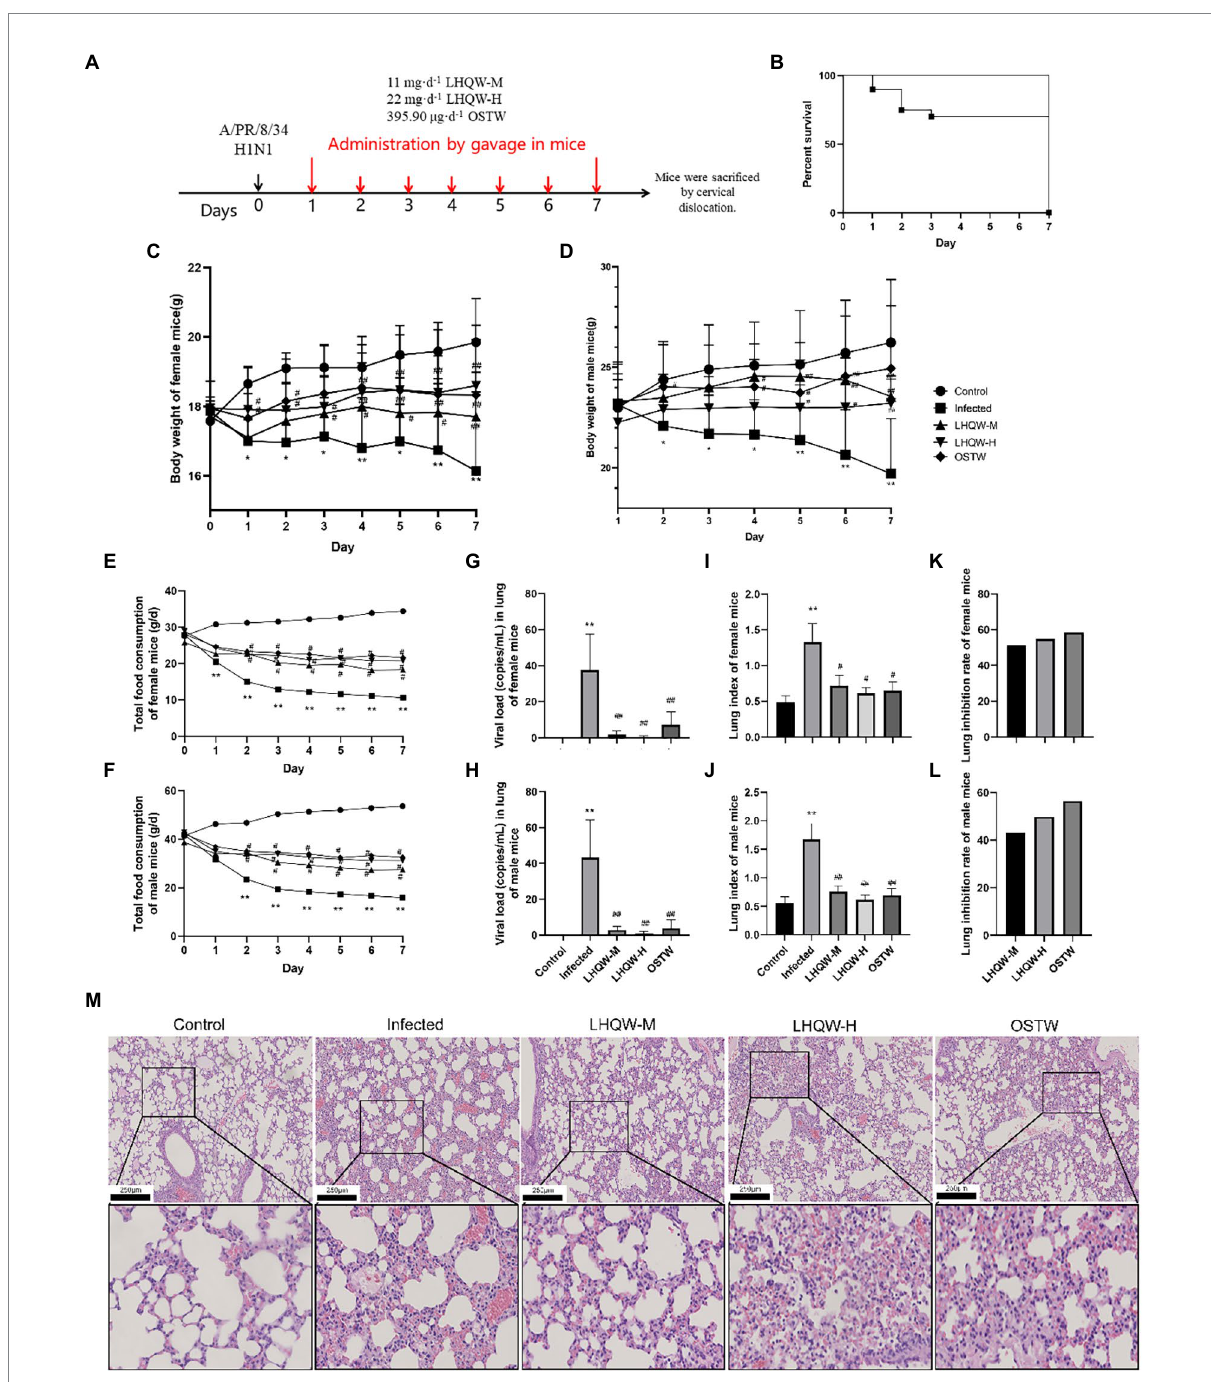
FIGURE 1 LHQW improves lung injury and inflammation. (A) Flow diagram; (B) Mouse survival curve: The survival rate of mice in other groups except the infected group (72%) were 100%( n = 90); (C) Weight changes of female mice infected with influenza virus (G) ( n = 45) ; (D) Weight changes of male mice infected with influenza virus (g; n = 45); (E) Daily changes of total food consumption of female mice in each group (g/d; n = 45); (F) Daily changes of total food consumption of male mice in each group (g/d; n = 45); (G) Viral load (copies/mL) in lung tissue of female mice ( n = 45); (H) Viral load (copies/mL) in lung tissue of male mice ( n = 45); (I) Lung index of female mice ( n = 45); (J) Lung index of male mice ( n = 45); (K) Lung inhibition rate of female mice ( n = 45); (L) Lung inhibition rate in male mice ( n = 45); (M) HE staining of mouse lung tissue (200 and 400 times). The mice were randomly assigned to the virus infected group (infected), 11 mg·d − 1 (LHQW-M) Lianhua Qingwen capsule, 22 mg·d − 1 (LHQW-H) Lianhua Qingwen capsule high-dose group and 395.90 μ g·d − 1 oseltamivir group (OSTW). Compared with control group, * p < 0.05, ** p < 0.01; Compared with infected group, # p < 0.05, ## p <